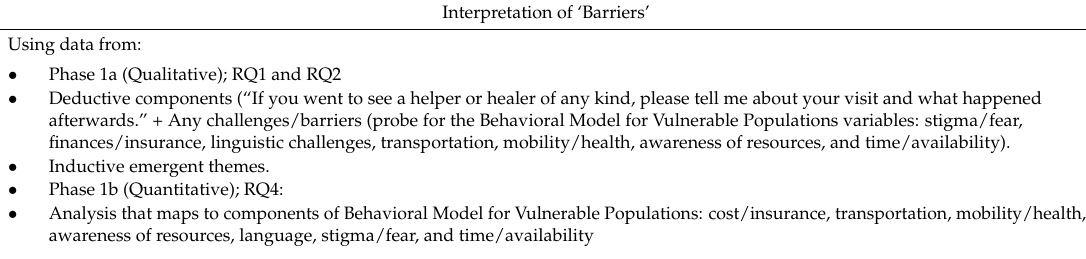
Table 1. Example of matrix for integrating and interpreting results. (Note: this combines actual and hypothetical